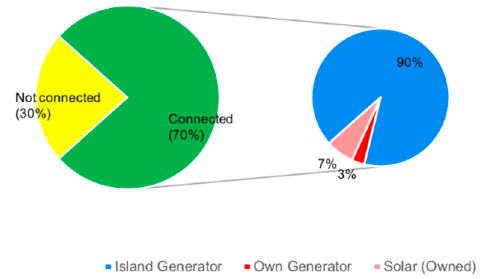
Figure 4. Access to electricity in Pangan-an Island.